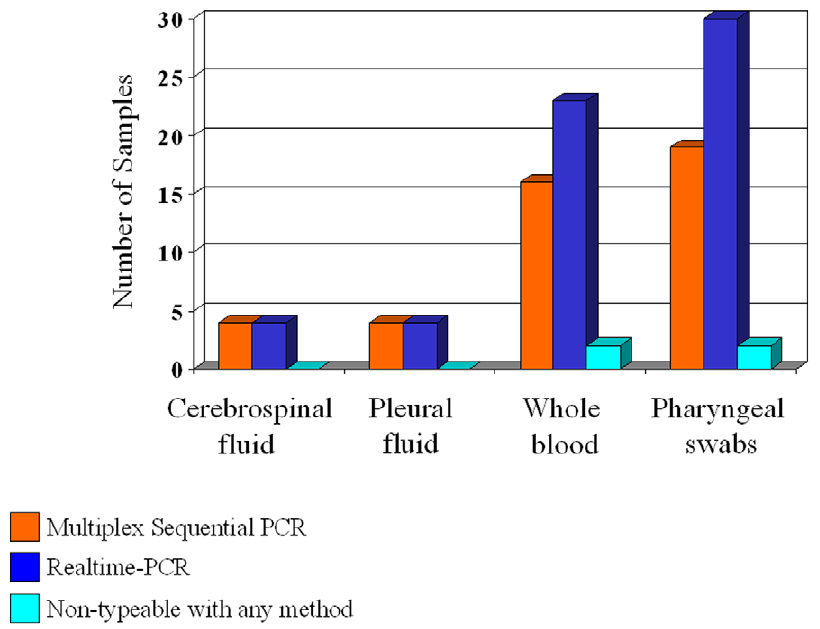
Figure 1. Number of typeable or non-typeable samples obtained from patients with culture-negative invasive pneumococcal infections as evidenced by Multiplex Sequential PCR or Realtime-PCR (sensitivity of Realtime vs Multiplex Sequential PCR p=0.0004; 95%CL 1.98–17.05).